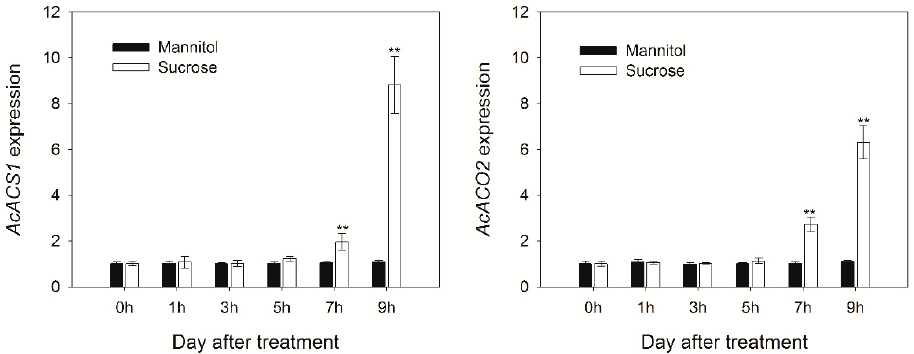
Figure 3. The time course of sucrose induced the expression of AcACS1 and AcACO2 genes encoding enzymes involved in ethylene biosynthesis. Kiwifruit flesh cubes (1 cm thick) were prepared from pulp tissue. Immediately after cutting, the tissue cylinders were immersed in 200 mL of equilibration solution (sucrose-treated: 50 mM Sucrose, mannitol-treated (control): 50 mM mannitol). Freshly cut discs were washed by gently stirring for 0, 1, 3, 5, 7, and 9 h in equilibration solution, and gene expression was examined by qRT-PCR. The data are expressed as the mean ± S.D. The asterisks indicate a significant difference relative to mannitol treatment according to a student’s t -test (** p < 0.01).